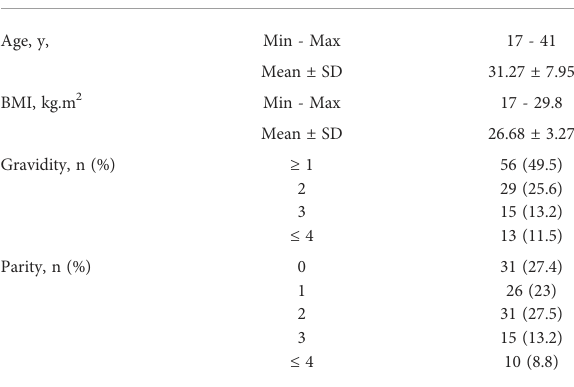
TABLE 1 Demographic and clinical characteristics of 113 women with ovarian cyst undergoing laparoscopic cystectomy.